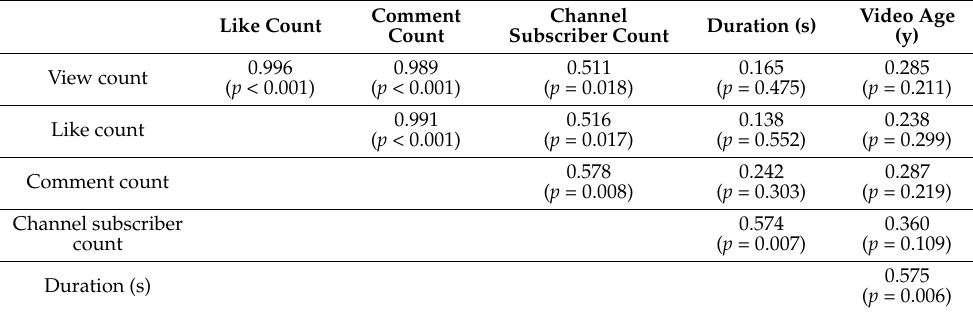
Table 5. Pearson correlation between the viewing